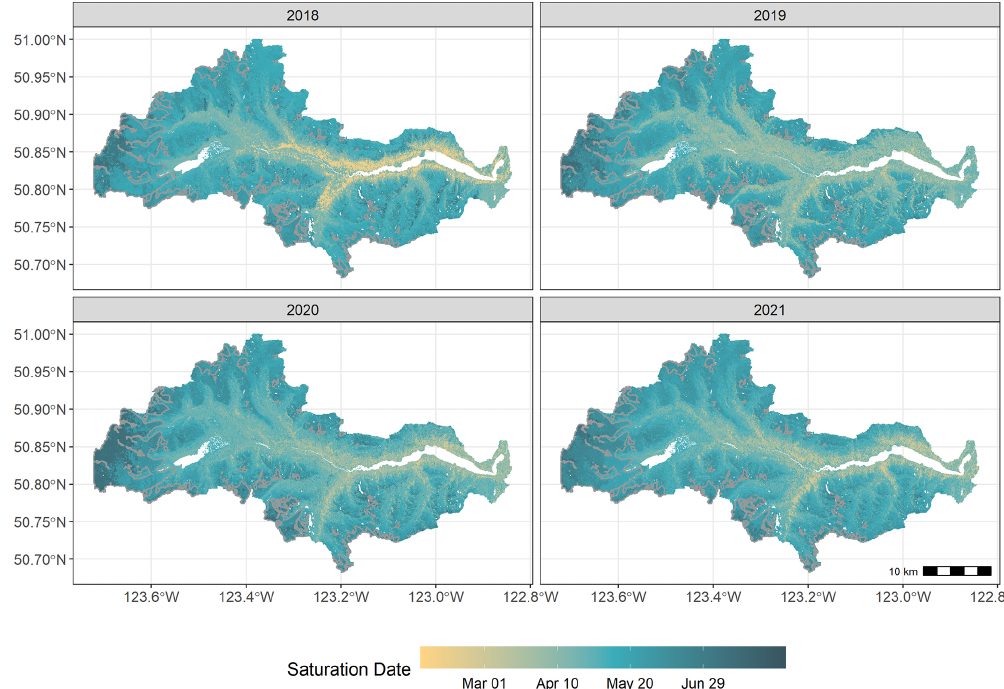
Figure 6. Estimates of snowpack saturation (snowmelt onset) from Sentinel-1 SAR images of the La Joie Basin. Snowmelt onset estimates are inferred from minima in SAR time series.